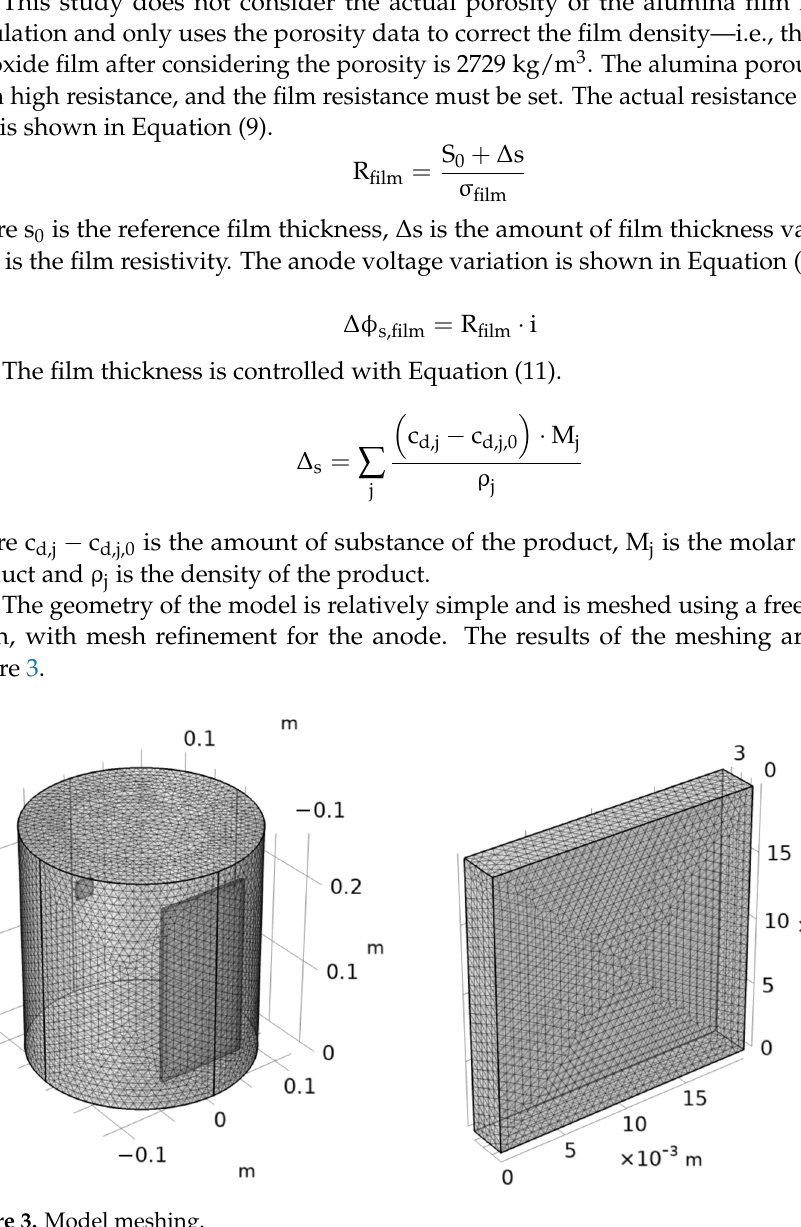
Figure 3. Model Figure 3. Model meshing.